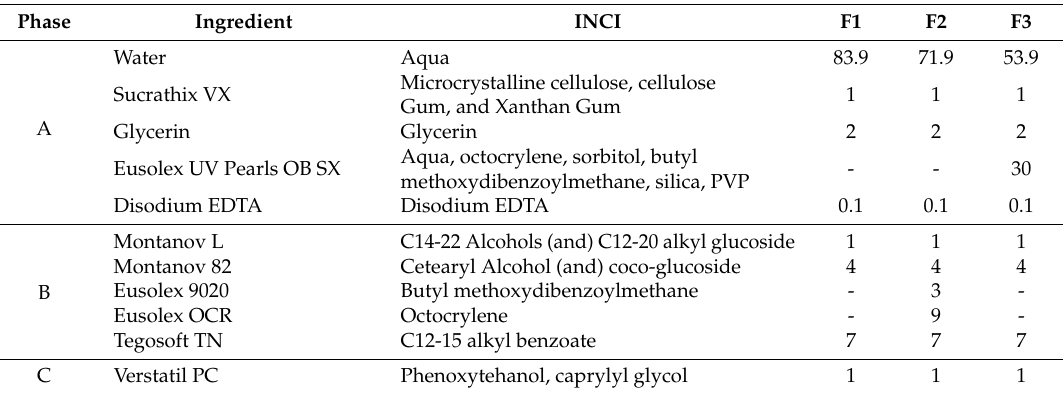
Table 1. Percentage composition of the